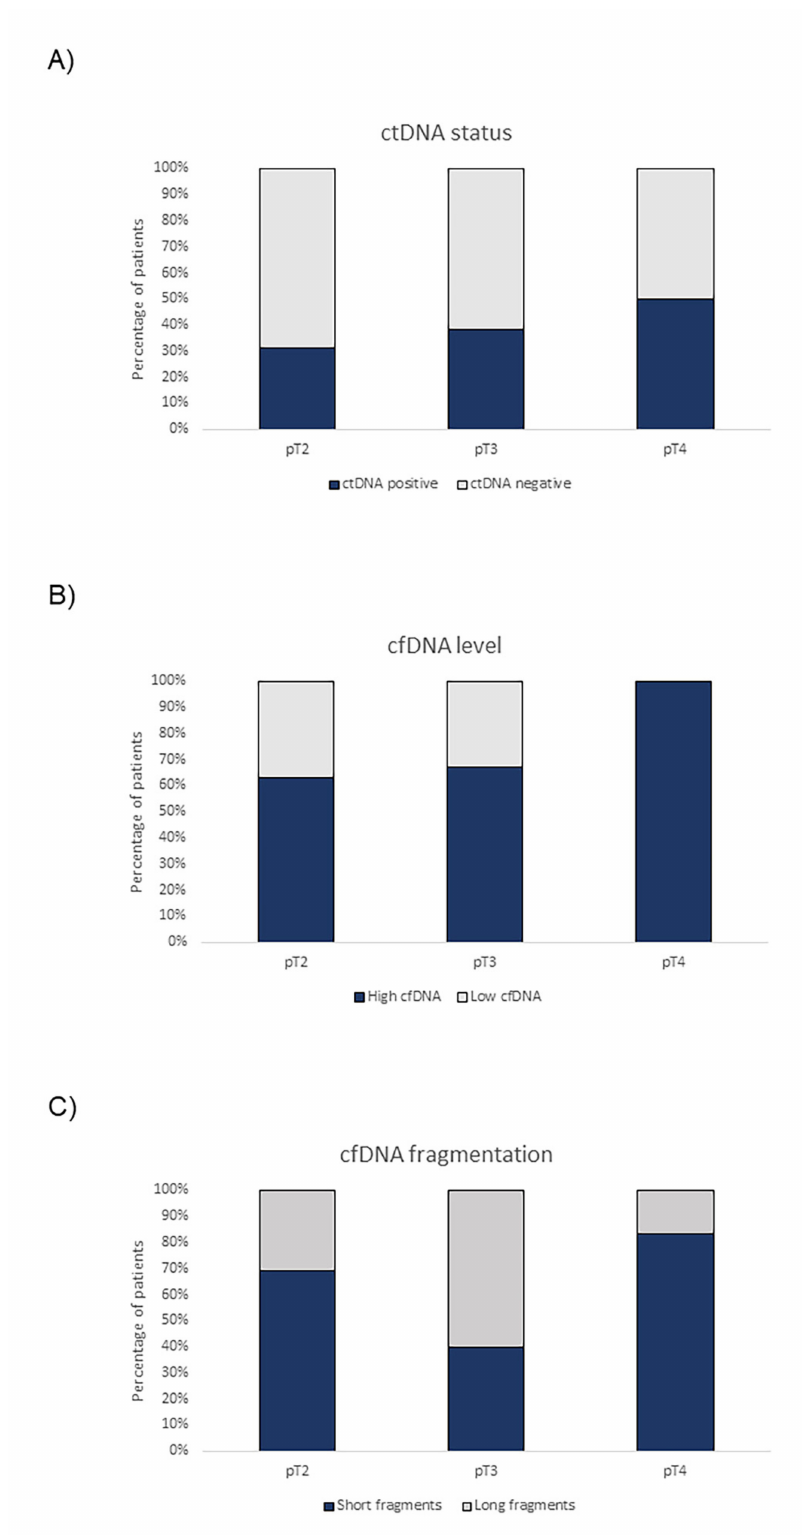
Figure 1. ( A ) ctDNA status, ( B ) cfDNA levels and ( C ) cfDNA fragmentation patterns at baseline according to the pathological state of MIBC